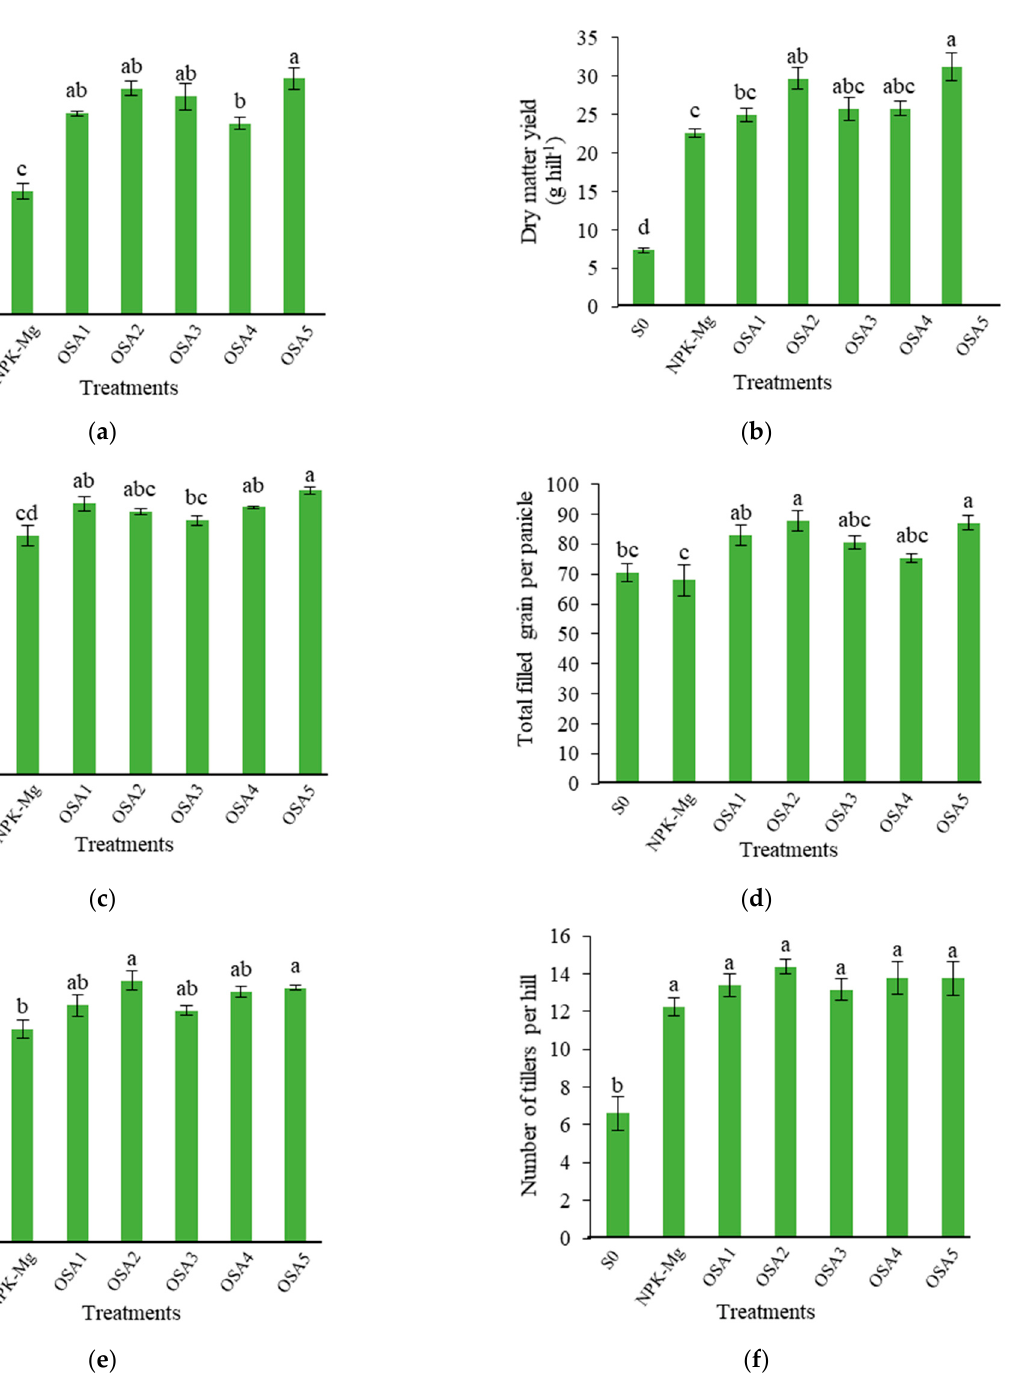
Figure 5. ( a ) Grain yield, ( b ) dry matter yield, ( c ) plant height, ( d ) total filled grain per panicle, ( e ) number of panicles per hill, and ( f ) number of tillers per hill of rice plants in relation to the addition of chemical fertilizers and organic soil amendments after the third cropping cycle. Means with different letters indicate significant difference using Tukey’s test at p ≤ 0.05 and error bars represent standard